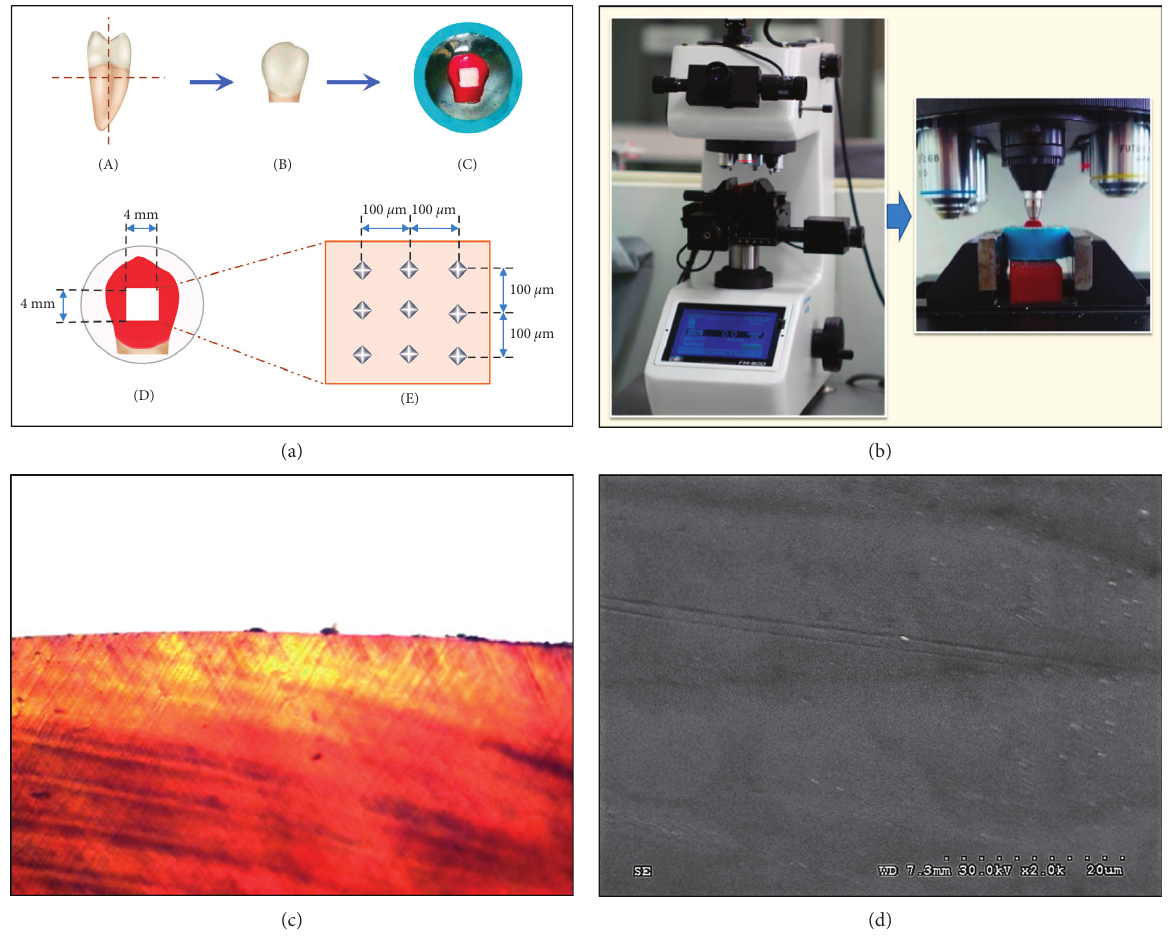
Figure 1: (a) The second premolar teeth (A) were cut in the horizontal direction below cementum-enamel junction for 1mm and vertically sectioned at the central groove in the mesiodistal direction (A). The crown (B) was embedded in the resin (C) and flattened the surface for 4 × 4mm 2 (D). The hardness was evaluated on the flatten area at 100 μ m far from each indentation (E) in the Vickers hardness testing machine (b). Polarized light micrograph (c) and scanning electron micrograph (X2.0K) (d) were used to verify the intact enamel for the tested